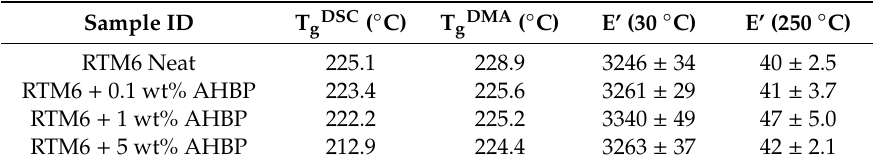
Figure 12. DMA curves of neat and filled systems. Table 2. Neat and filled systems DSC and DMA results.